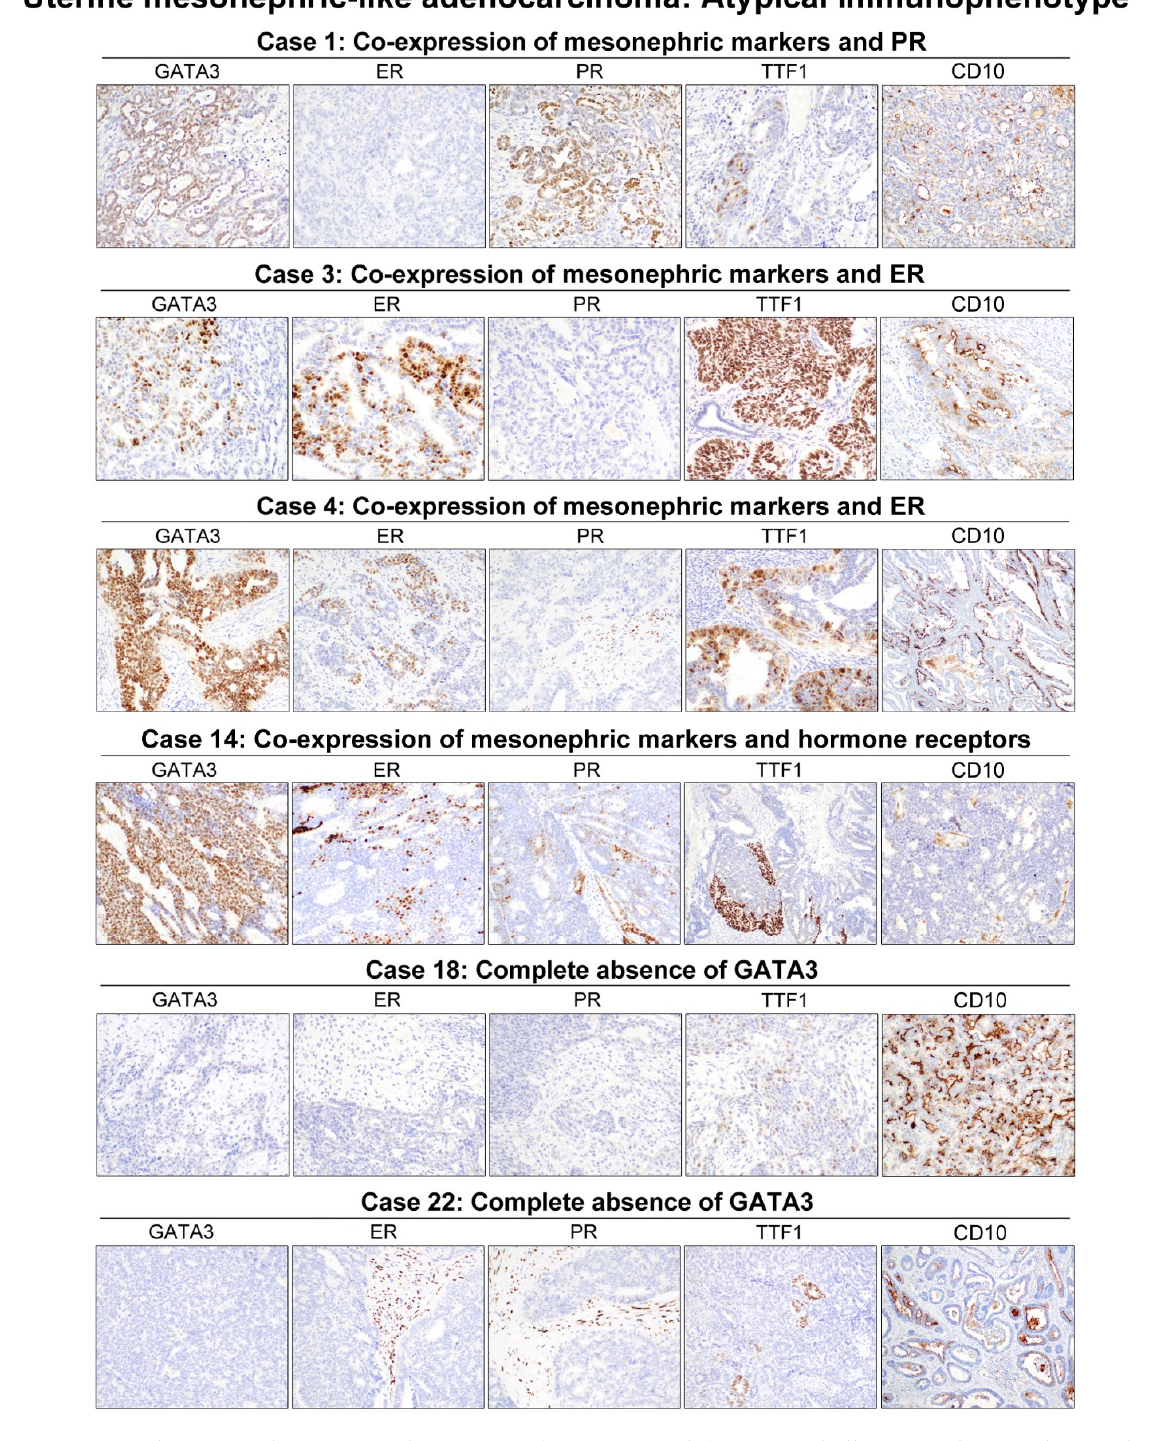
Figure 4. Atypical immunophenotypes. Three tumors (cases 1, 3, and 4) expressed all mesonephric markers and one hormone receptor simultaneously. Concurrent expression of GATA3, TTF1, ER, and PR was noted in one tumor (case 14); in this case, 95% of tumor cells expressed GATA3 with moderate-to-strong intensity whereas ≤ 25% of tumor cells expressed ER or PR. GATA3 was absent in cases (18 and 22) where TTF1 and CD10 were both positive. The tumor in case 18 was diagnosed as MLCS, in which both the epithelial and mesenchymal components were completely negative for GATA3, ER, PR, and TTF1.